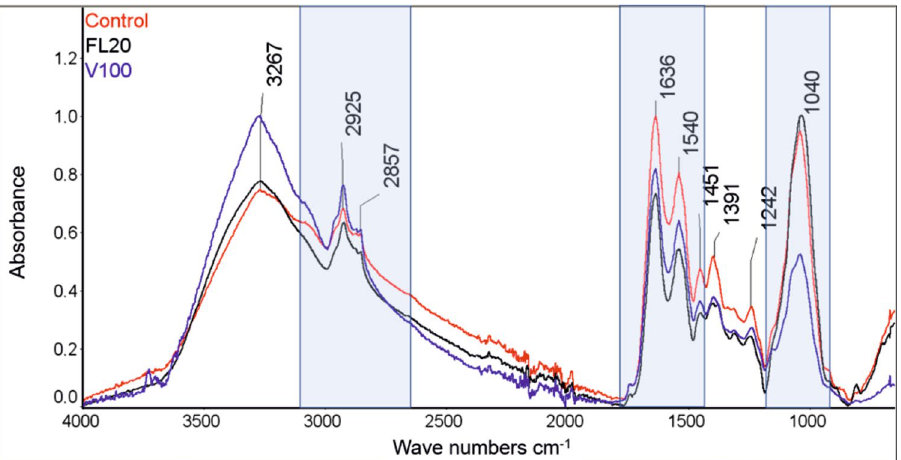
Figure 10. FTIR spectrum for the C. albicans control culture (Control) and after the treatment with Venetin-1 at 100 µg mL −1 (V100) and fluconazole at 20 µg mL −1 (FL20).